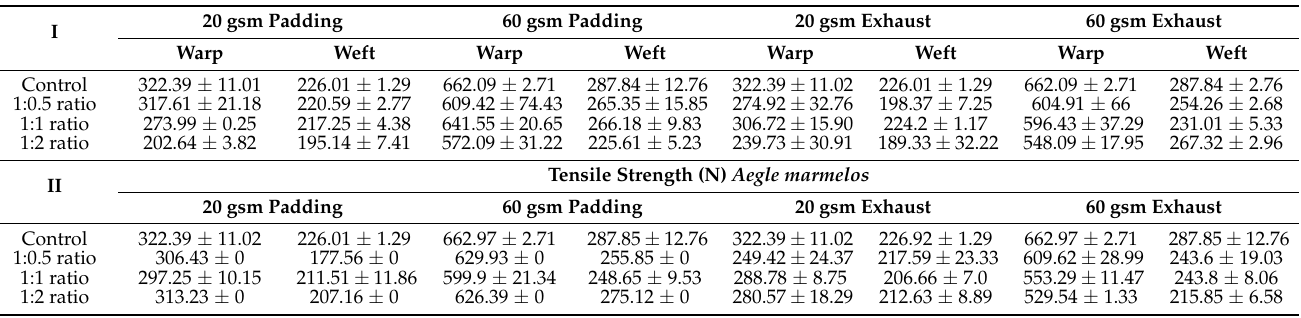
Table 5. Tensile strength (N) Moringa oleifera